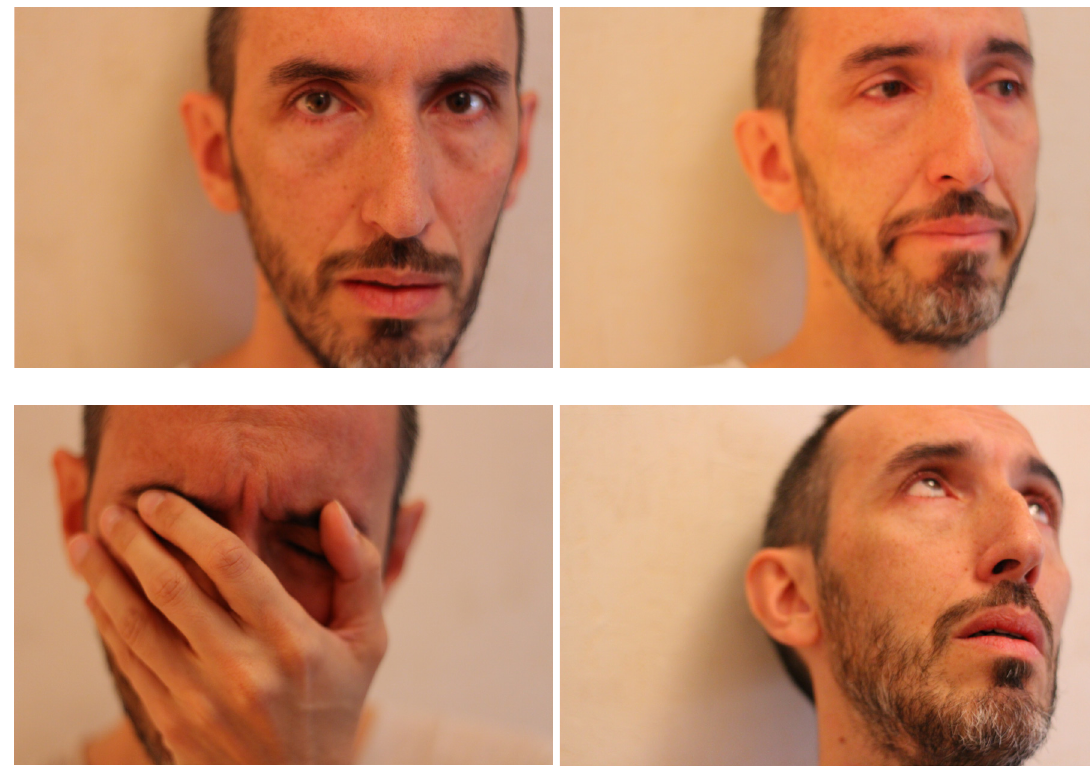
Figs. 14-17 Mathieu Montanier as Don Quichotte, in Tristes figures , (in prep.), photos: Sonia Thurel,